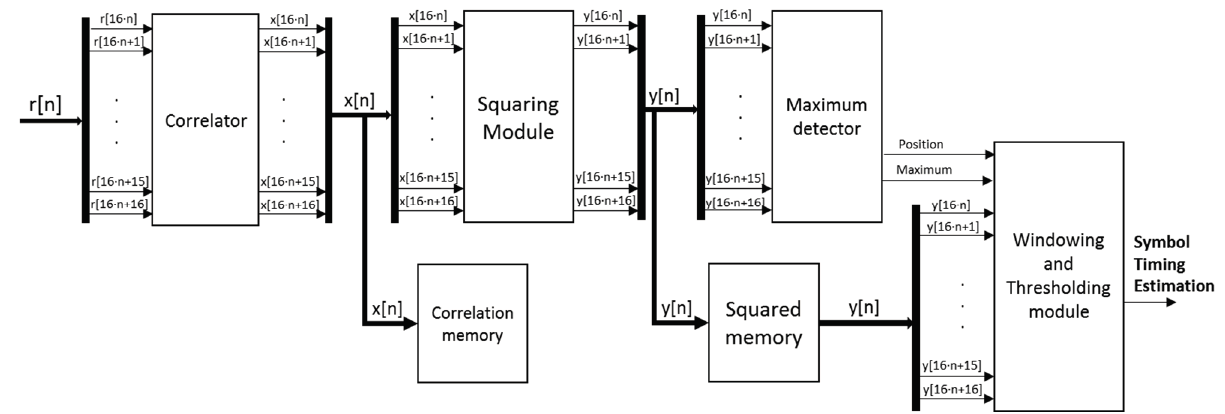
Figure 5. General block diagram of the architecture proposed for the implementation of the synchronization